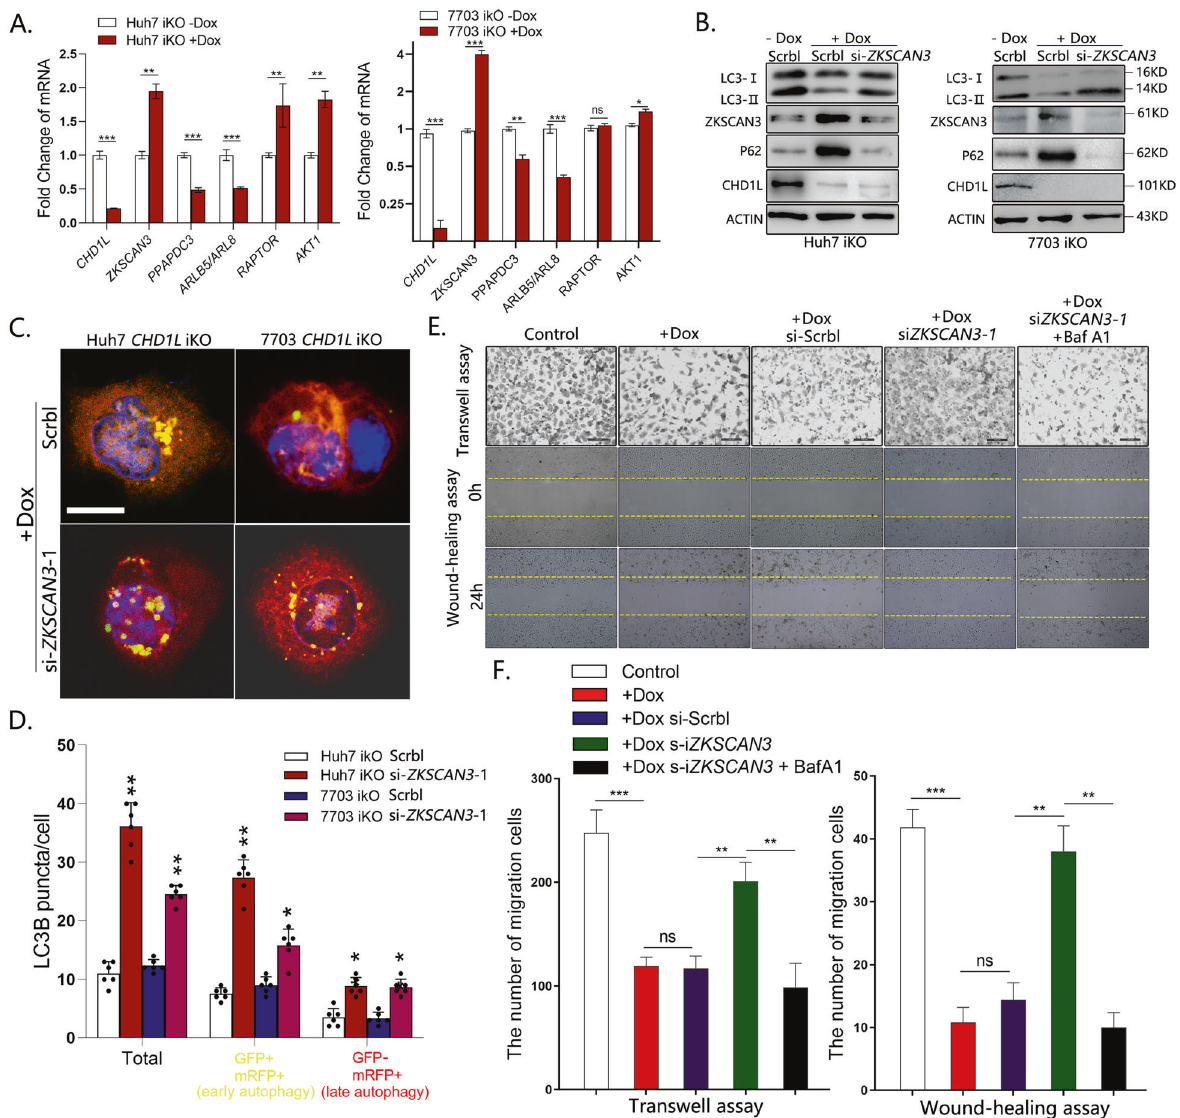
Fig. 5 Silencing ZKSCAN3 rescue the lacked autophagy and migration due to deleting CHD1L in vitro. A Huh7 and QGY-7703-iKO cells were detected for expression of indicated ZKSCAN3 downstream autophagy-related genes by fl uorescent quantitative RT-PCR (** P < 0.01; *** P < 0.001; Student ’ s t test). Values are shown as mean ± SD calculated from three parallel experiments. B . WB analysis for LC3 conversion changes in CHD1L deleted cells in response to ZKSCAN3 knockdown by si ZKSCAN3 -1, compared to Scrbl control. C , D Representative images showing starvation-induced GFP-mRFP-LC3 and mRFP-LC3 puncta accumulation in CHD1L deleted cells in response to ZKSCAN3 knockdown. GFP-mRFP-LC3 and mRFP-LC3 puncta per cell were quanti fi ed. Scale bar represents: 10 μ M (* p < 0.01; ** p < 0.01; Student ’ s t test; Data indicate mean ± SD; n = 5). Images/immunoblots are representative of three independent experiments. E, F. QGY-7703 cells treated as indicated (with PBS control, Baf A1 (40 nM)) were plated in the upper chamber of the fi lters for 24 h and then, the cells migrated to the underside of the Transwell insert were counted, scale bar: 100 μ m. Baf A1: 40 nM. QGY-7703 cells treated as indicated were subjected to wound-healing assay (Upper). Quanti fi cation of migration in Transwell assay and migrated area in wound-healing assay (Lower) (** p < 0.01; *** p < 0.001; ns no signi fi cant; Student t test; n =